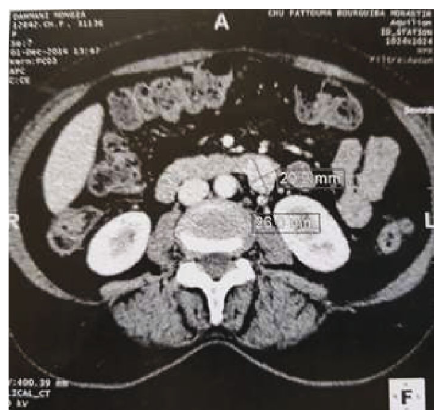
Figure 2: CT aspect of the tumor.